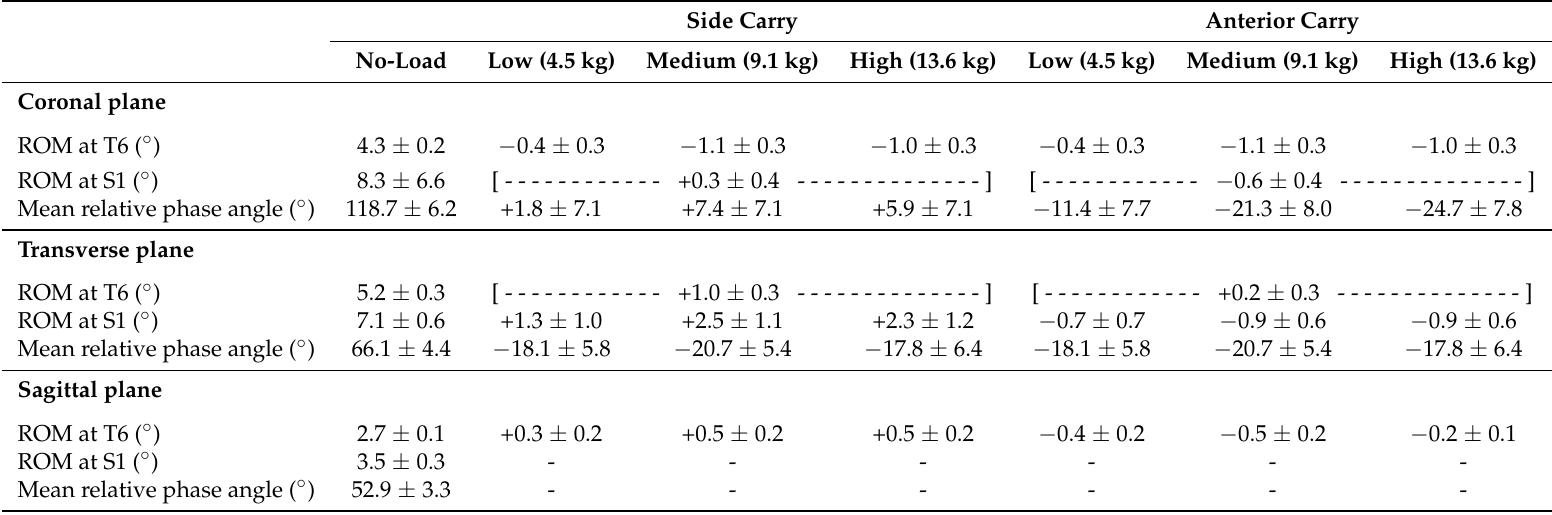
Table 5. Experiment-2 ( n = 10) estimated marginal mean ± SE for the No-load condition, and statistically significant mean differences ± SE relative to the no-load condition by carrying mode and load level, at average values of centered relative speed. Significant mean differences relative to the no-load condition by carrying mode across different load levels are within the square brackets (i.e., [- - mean ± SE -